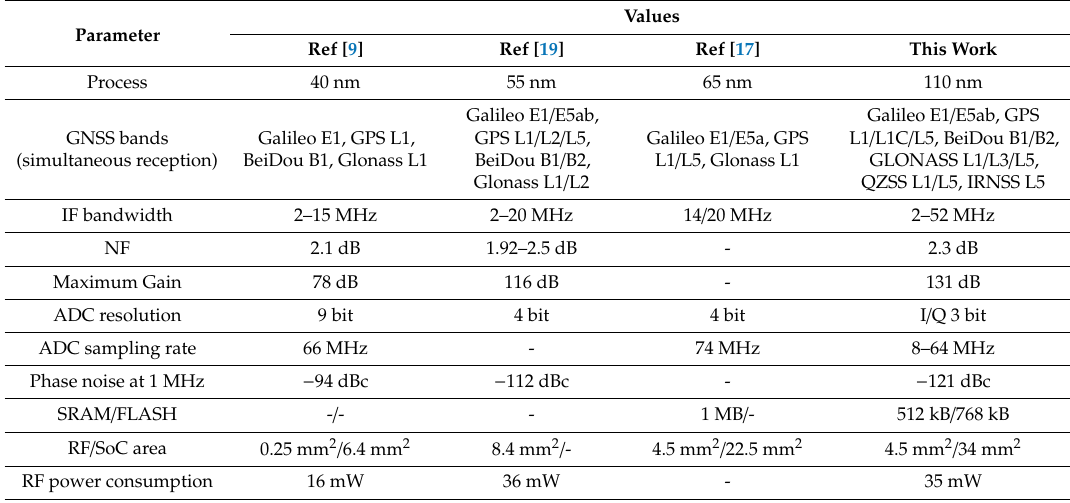
Table 1. Comparison with previously published multiband GNSS